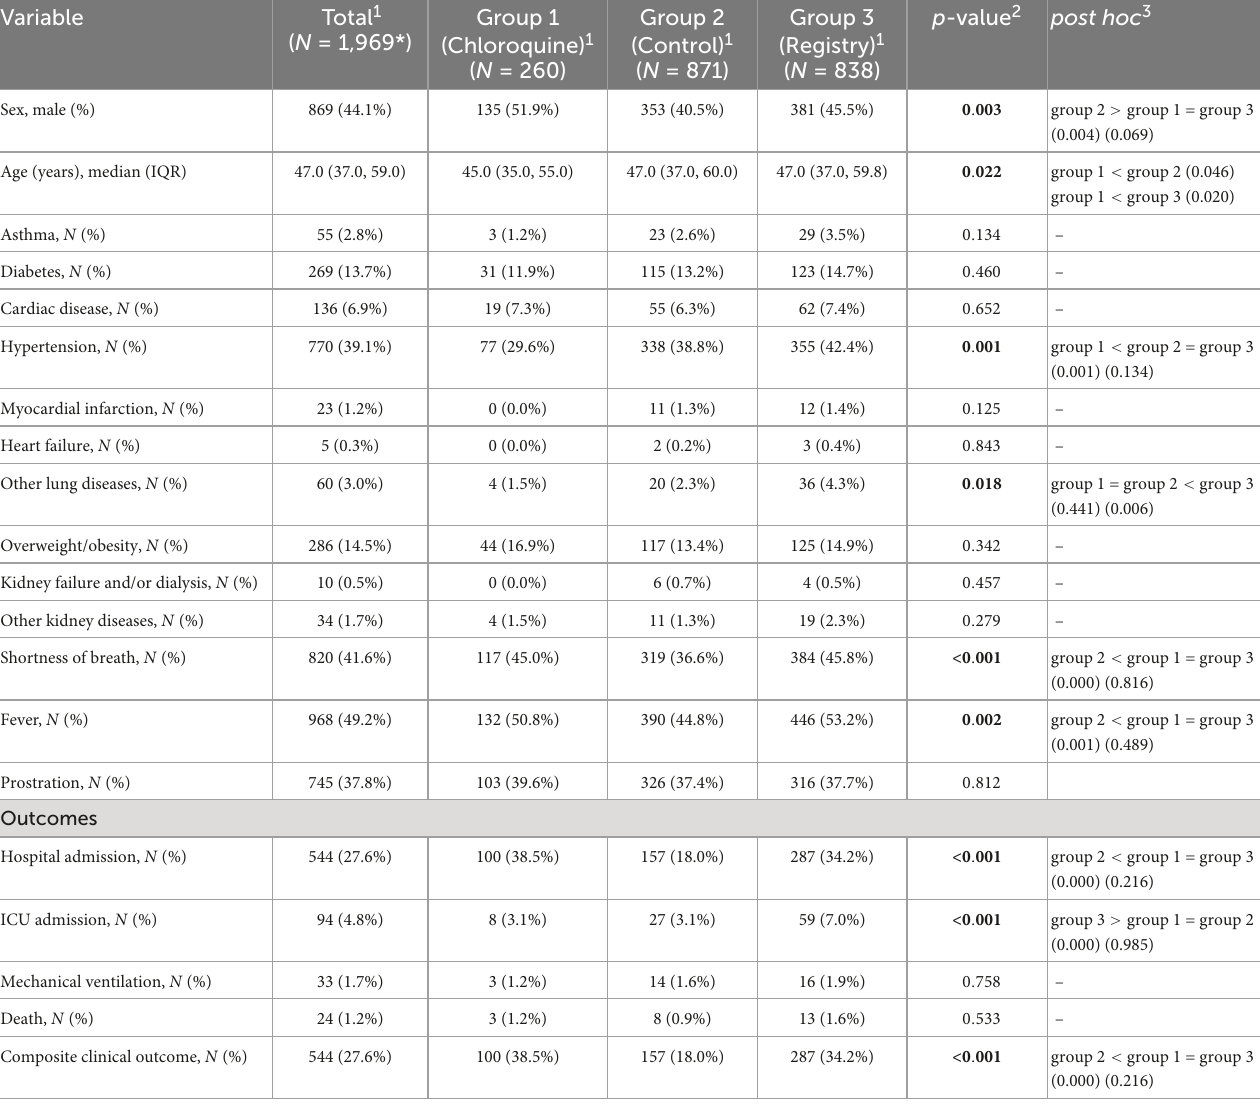
TABLE 2 Baseline characteristics and rates of outcomes of interest of patients included in the phone clinical follow-up, and comparison between treatment groups.